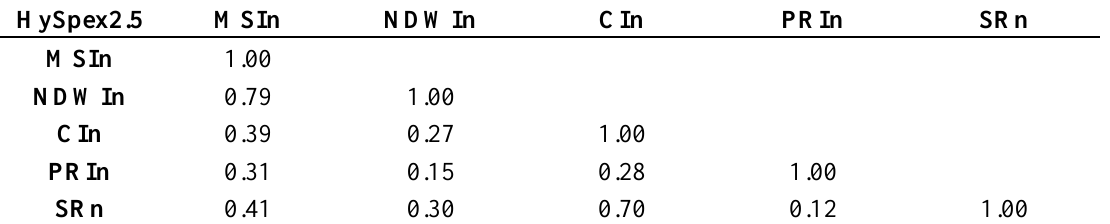
Table 3. Correlation between the selected spectral indices for the original “HySpex2.5” dataset after eliminating outliers and normalizing all indices in the range 0–1.